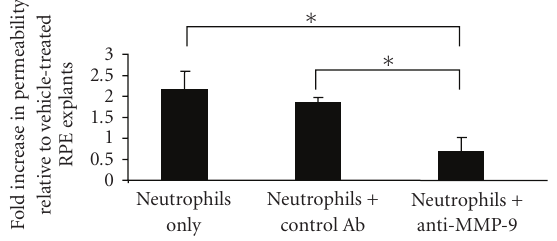
Figure 7: Anti-MMP-9 antibody attenuated neutrophil-mediated increase in permeability. The neutrophils were pre-treated with either anti-MMP-9 antibody or control antibody followed by incubation with explants for 3 hours at 37 ◦ C. The apparent permeability was determined by [ 3 H]-mannitol flux and the data were presented as the fold increase in permeability relative to vehicle-treated samples. ∗ represents P < .